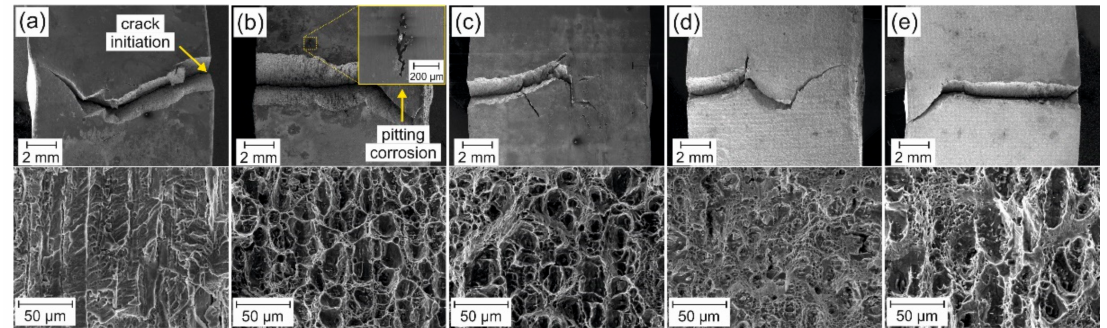
Figure 9. SEM images of cracked samples ( top ) and detail of the fracture surface ( bottom ) after 3-point bend testing: ( a ) baseline, ( b ) sensitized baseline, ( c ) sensitized LSP IR, ( d ) sensitized LPwC IR and ( e ) sensitized LPwC